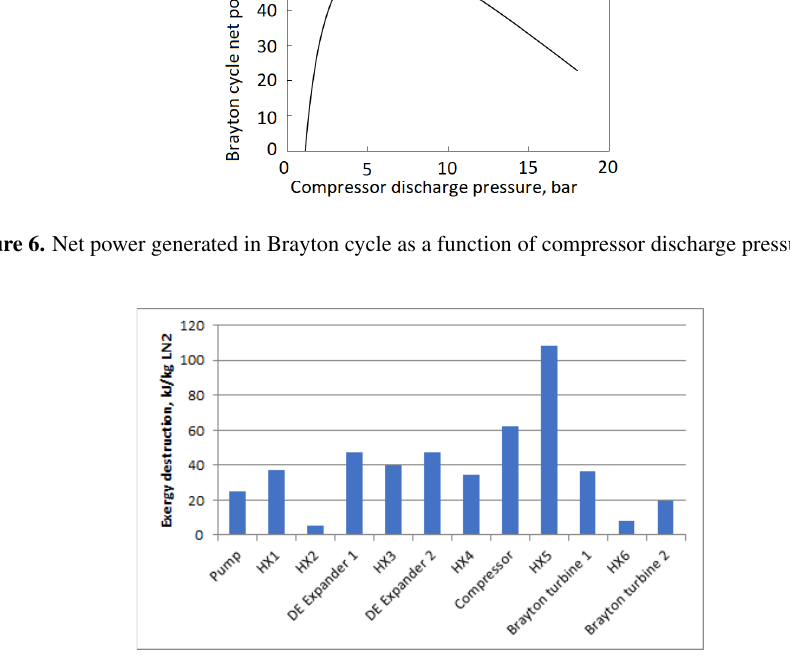
Figure 7. Exergy losses in combined system (for 100 bar pump pressure and 5.6 bar compressor discharge